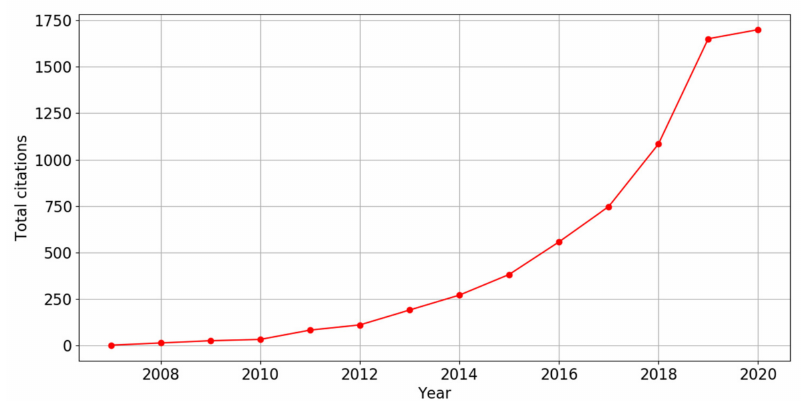
Figure 9. Total citations per year including percentage change (NSGA-II in scheduling).